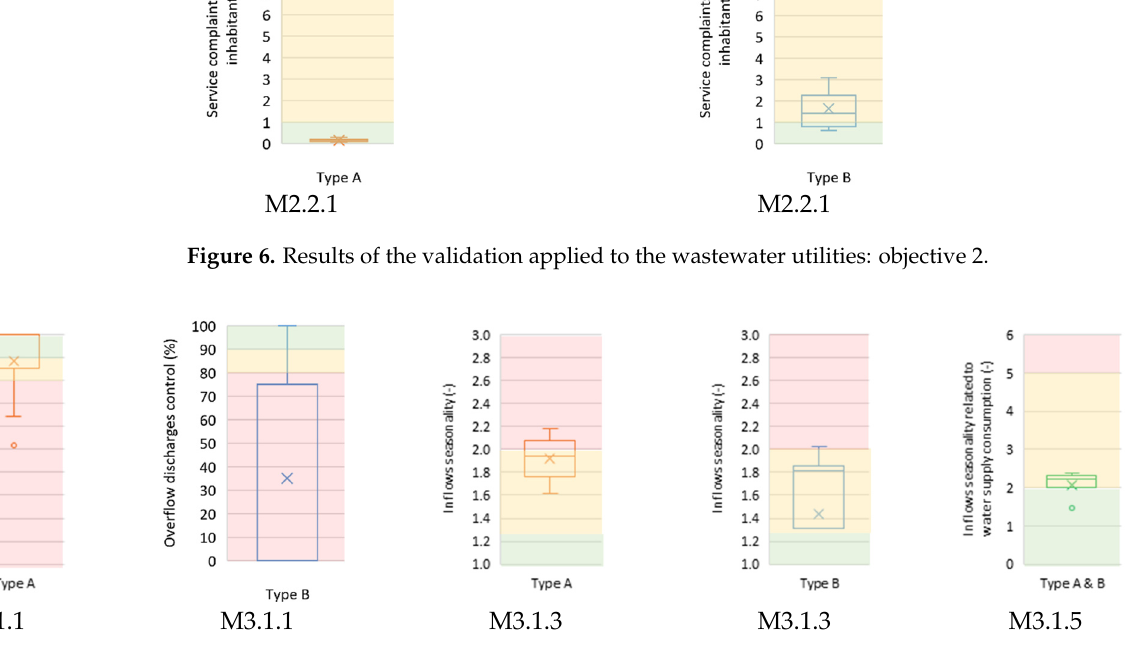
Figure 7. Results of the validation applied to the wastewater utilities: objective 3.